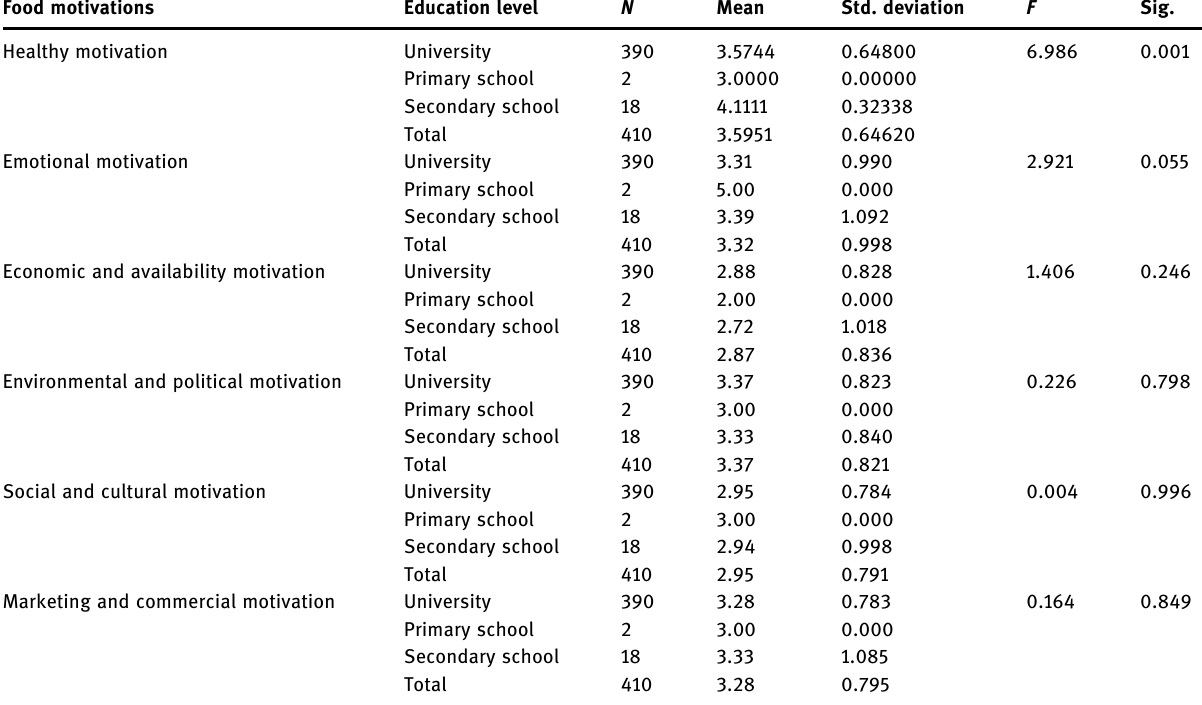
Table 4: ANOVA and mean results of education degree and food motivation factors